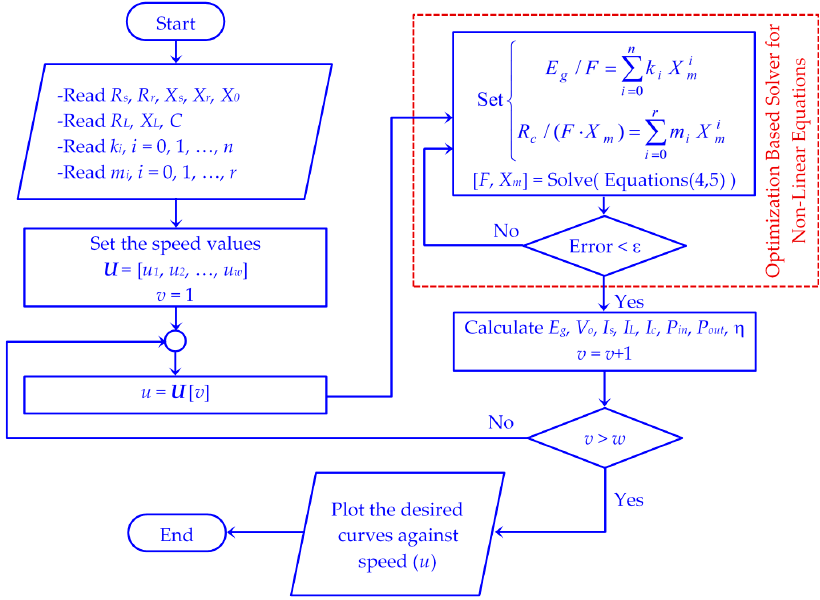
Figure 6. Flowchart of the developed optimization program to obtain the performance of the self-excited induction generator (SEIG).